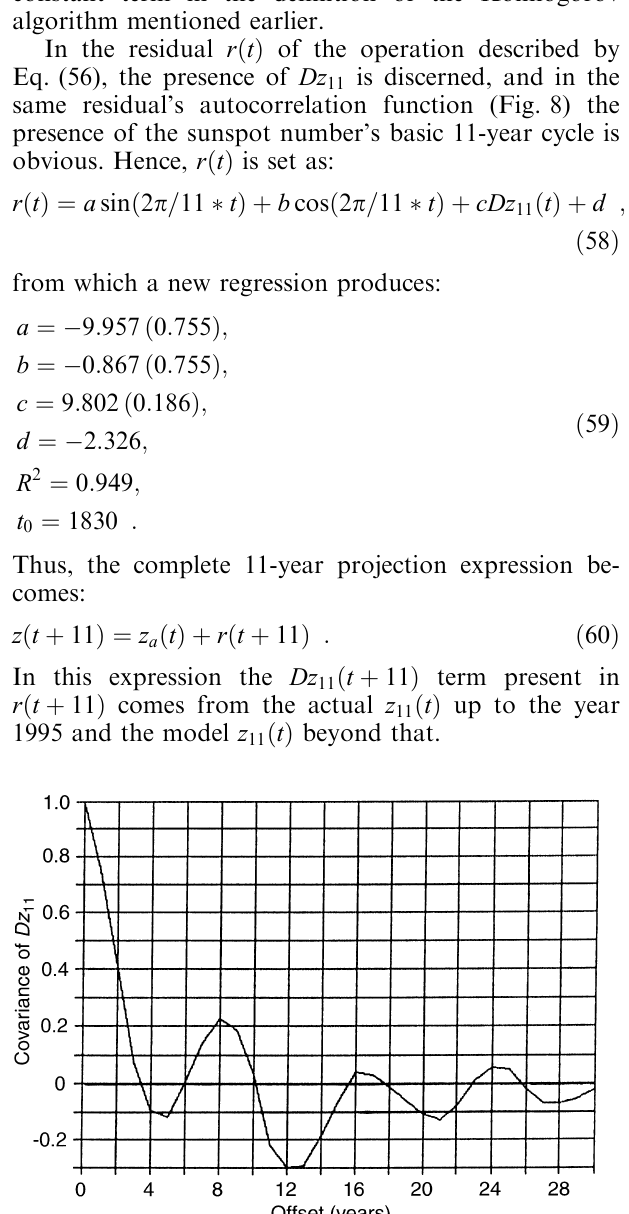
Fig. 9. Sunspot number 11-year projection